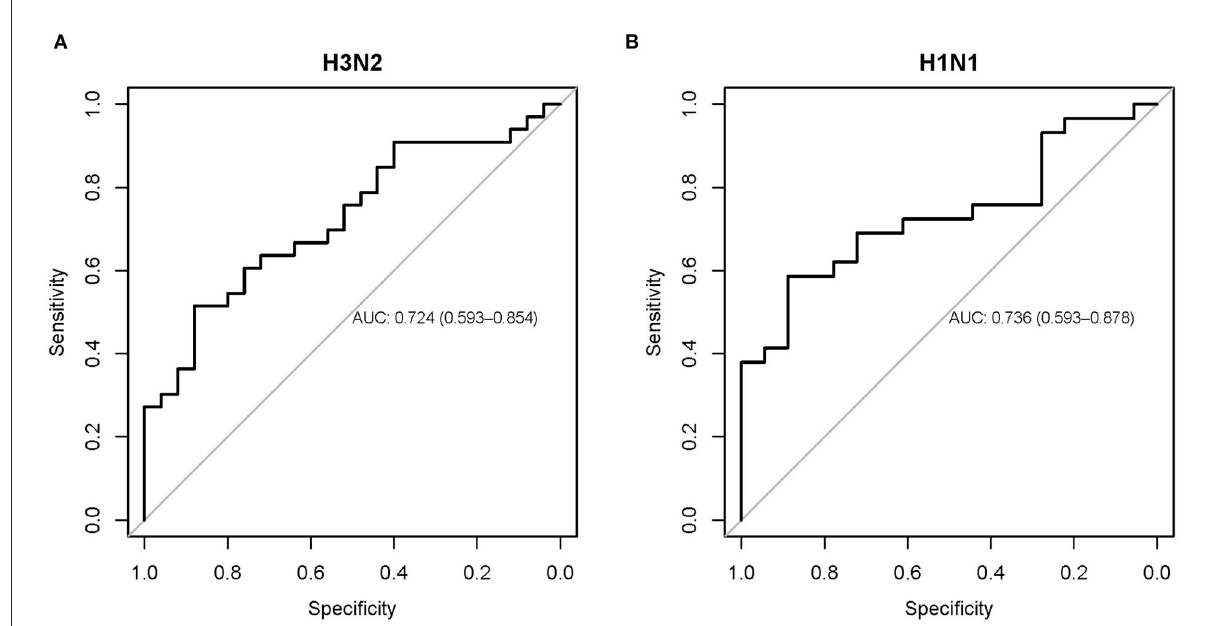
FIGURE6 Receiver operating characteristic curve showing the performance of the baseline NLR for predicting influenza susceptibility on the H3N2 (A) and H1N1 (B) cohorts.